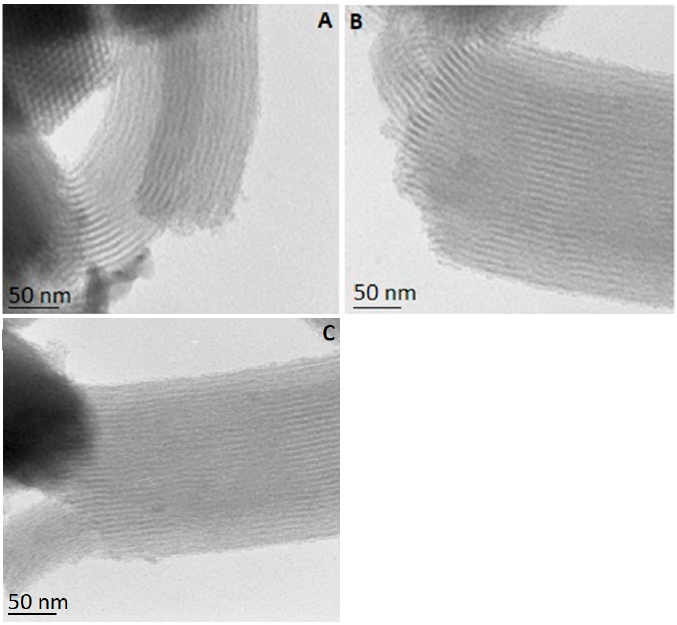
Figure 4. TEM images of ( A ) SBA-15-pr-NH 2 , ( B ) SBA-15-pr-NH 2 :PBZ, and ( C )